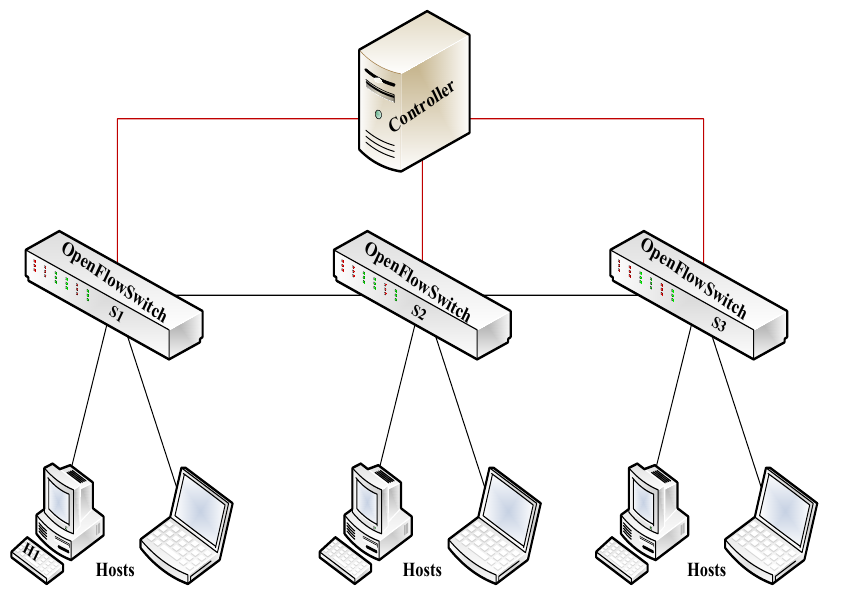
Figure 4. Single SDN Switch Scenario (4S).